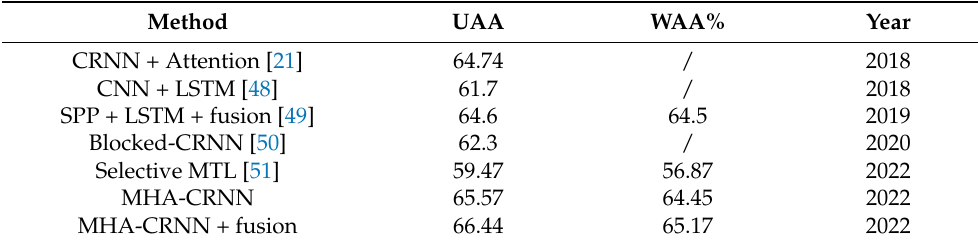
darker the color on the diagonal, the better the task prediction for the category. With